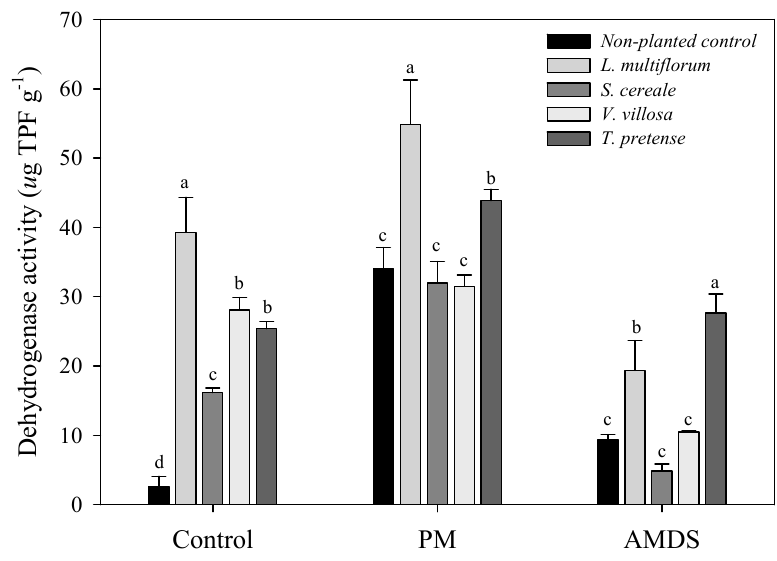
Figure 4. Dehydrogenase activity (i.e., the detection of triphenylformazan (TPF)) in soils with different types of cultivated plants ( Loliummultiflorum and Secalecereale (Poaceae family representatives) and Trifoliumpratense and Viciavillosa [Leguminosae family representatives]) and amendment treatments (Control; PM, pig manure; AMDS, acid mine drainage sludge). Different letters indicate significant differences among the NPC (nonplanted control) and the four plant species with the same treatment, using Tukey’s test. Error bars represent ± standard deviation of three replicates ( n = 3).